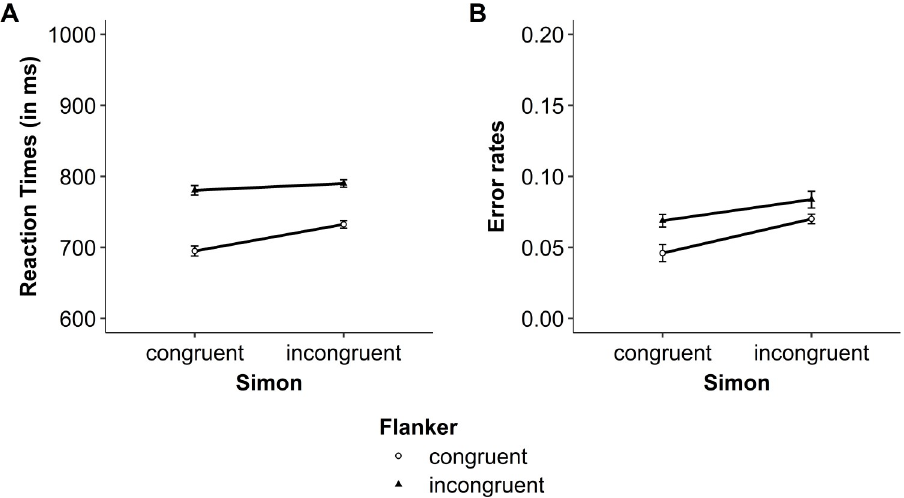
Fig 9. Experiment 3: Modulation of the flanker congruency effect by Simon congruency within a trial. (A) Mean reaction times (RT) and (B) mean raw error rates for both flanker and Simon congruency. Error bars represent within- subject confidence intervals [see 45, 46].